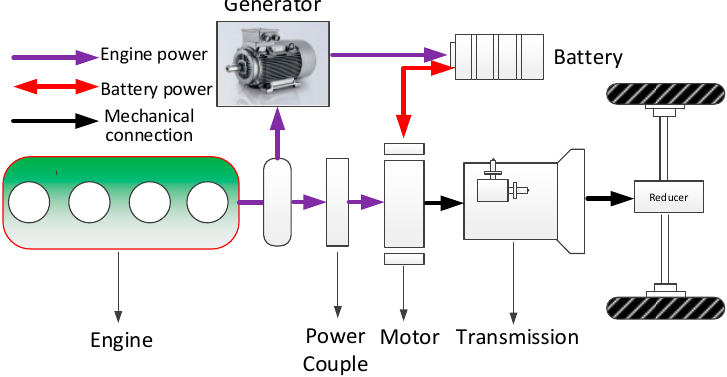
Figure 3. Power-split hybrid electric vehicle.